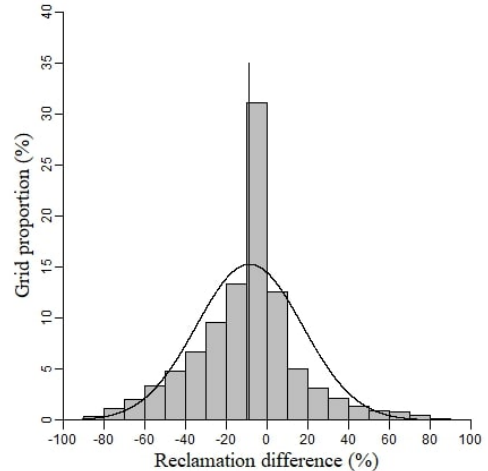
Figure 8. Comparison of reconstructed and remote sensing data. ( a ) Cropland reconstruction for 1980; ( b ) remotely sensed cropland data in 1980; ( c ) difference between ( a ) and ( b ).